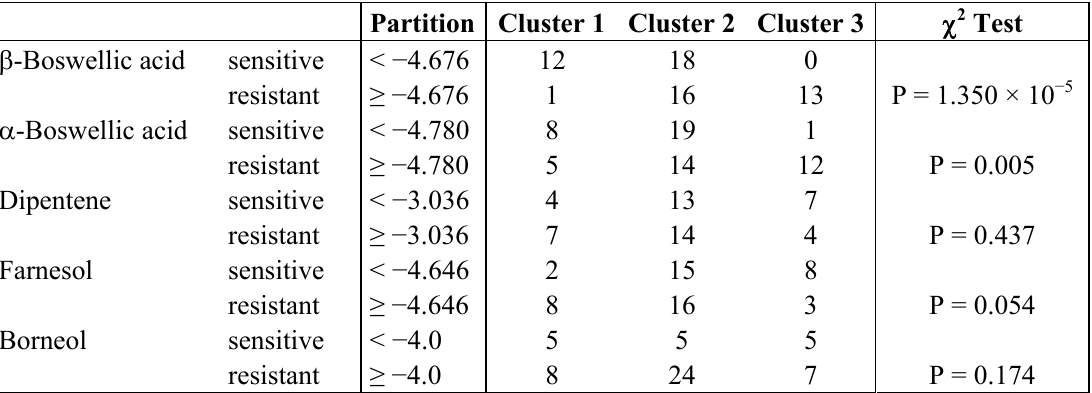
Table 4. Separation of clusters of 60 cell lines obtained by hierarchical cluster analysis for β -boswellic acid shown in Figures 3B in comparison to other phytochemical constituents of Boswellia carterii. The log IC median values (M) of each compound were used as 10 50 cut-off values to define cell lines as being sensitive or resistant. P > 0.05 was considered as not significant ( χ 2